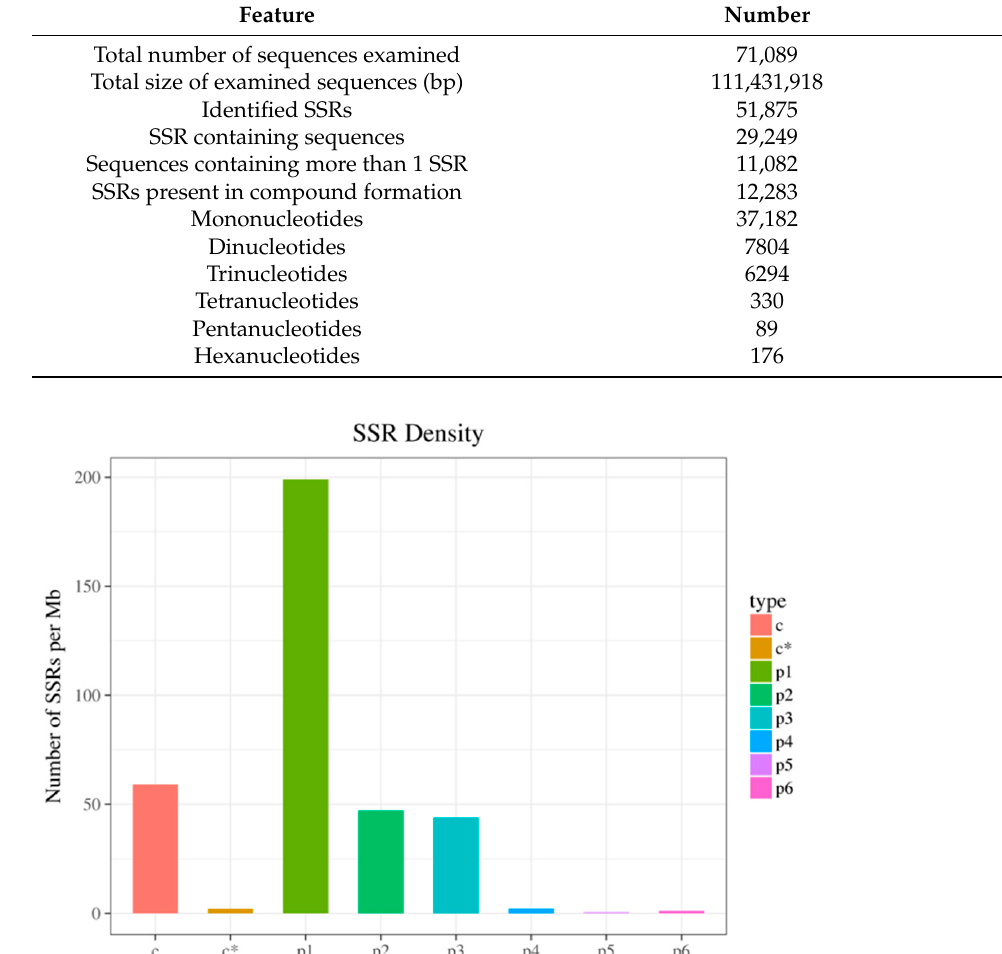
Table 4. Unigene annotation statistics.